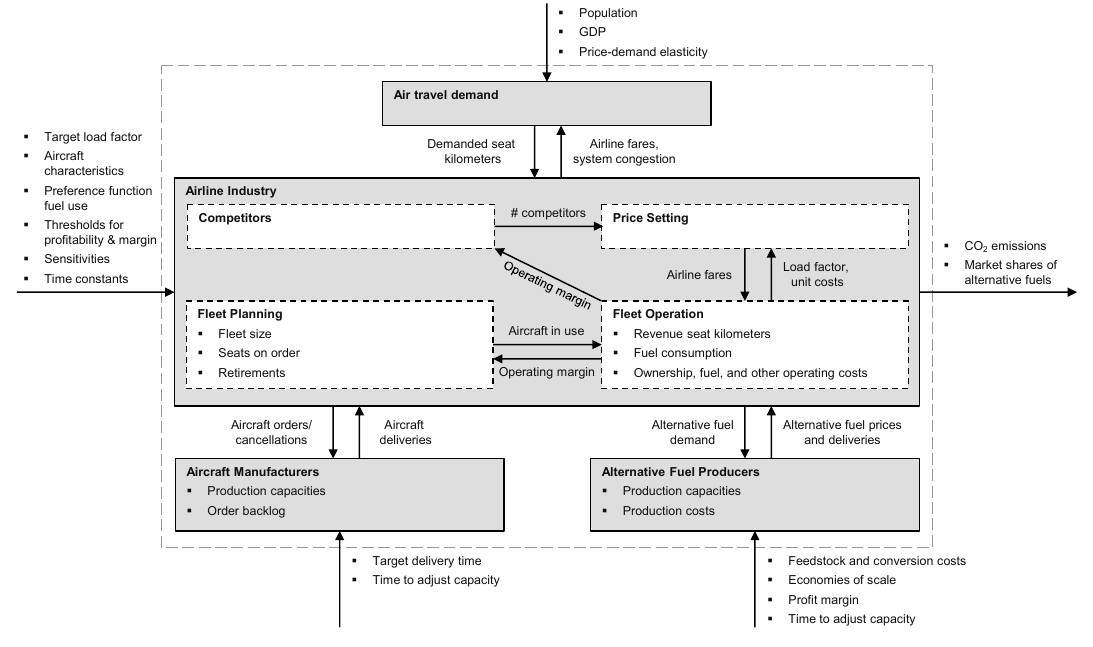
Figure 1. Concept of the simulation model.